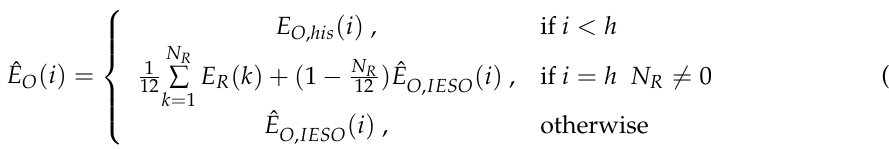
Figure 2. Concept of the correction method to improve the forecasting accuracy of ˆ λ HEU for the current time interval.